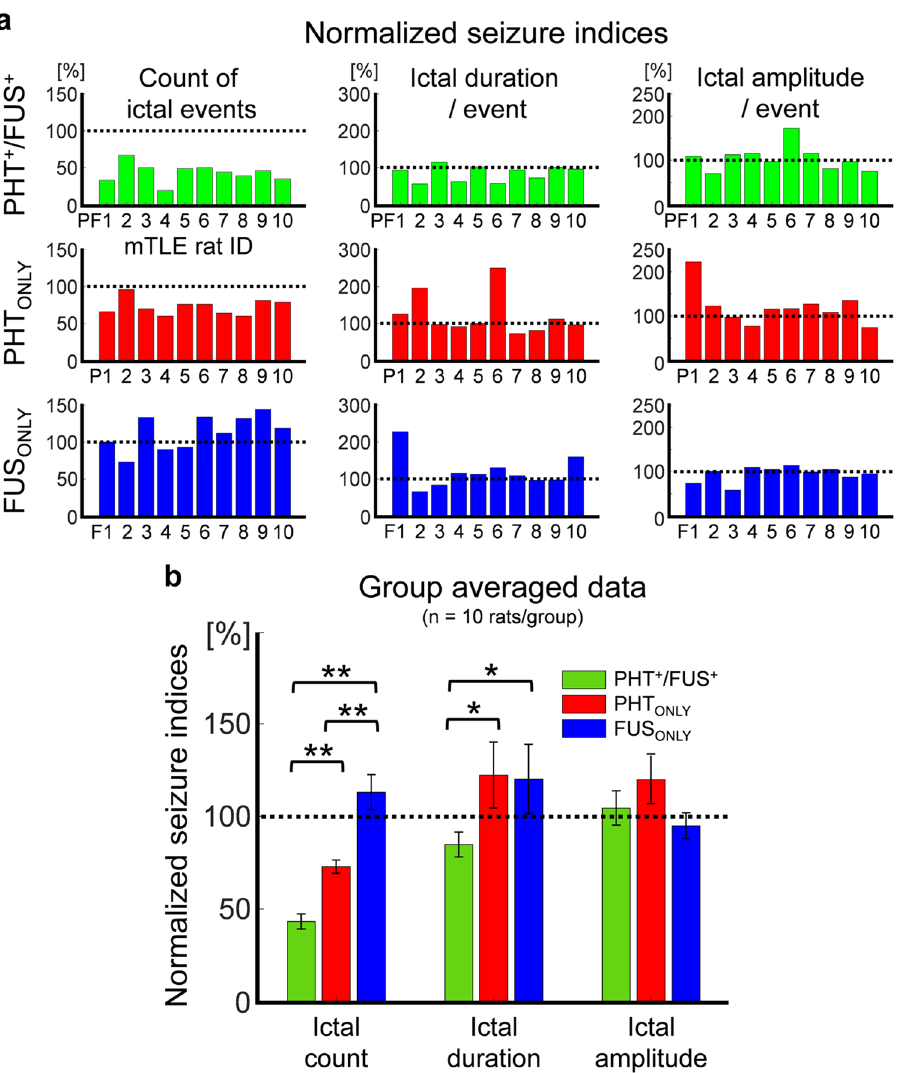
Figure 5. Illustrations of the normalized seizure indices. The post-intervention seizure indices (count of ictal events, ictal duration/event, and ictal amplitude/event) were normalized to pre-intervention seizure indices from the PHT + /FUS + (green), PHT ONLY (red), and FUS ONLY (blue) groups (n = 10 rats/group). ( a ) Individual rat’s normalized data from Fig. 4b. ( b ) Group averaged normalized seizure indices from ( a ), shown as mean ± standard error. * p < 0.05 ( t -test, one-tailed), ** p < 0.01 (one-way ANOVA with Tukey–Kramer post-hoc